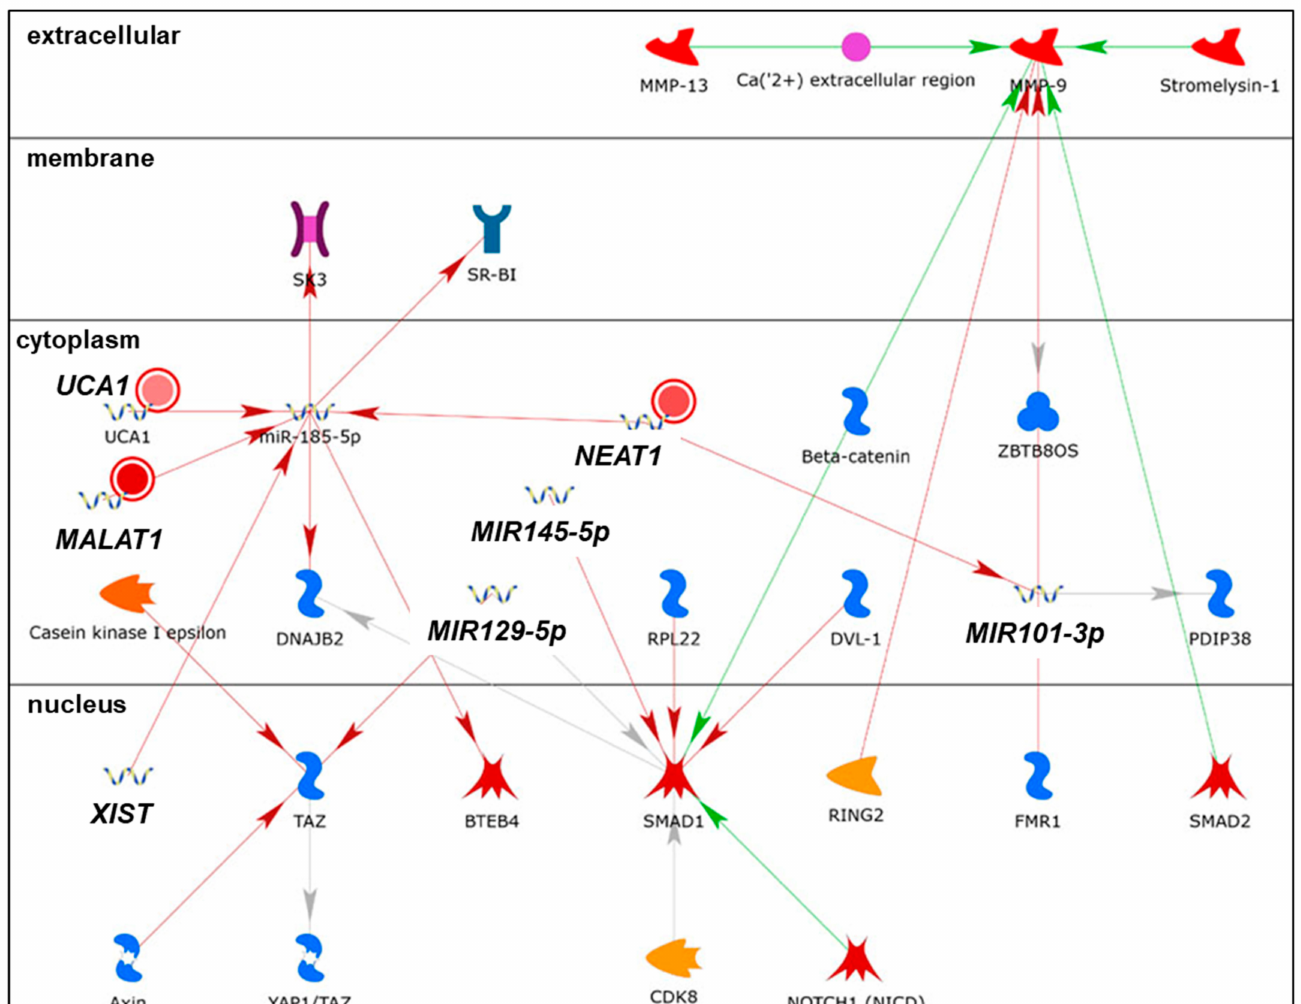
Figure 8. Network 3: NEAT1, MALAT1, UCA1 , miR-185-5p, and S MAD1 , identified in lncRNAs upregulated by miR-29b-1- 3p and miR-29a-3p in MCF-7 and/or LCC9 cells by MetaCore analysis. Green lines with arrows = stimulation; red lines with arrows =